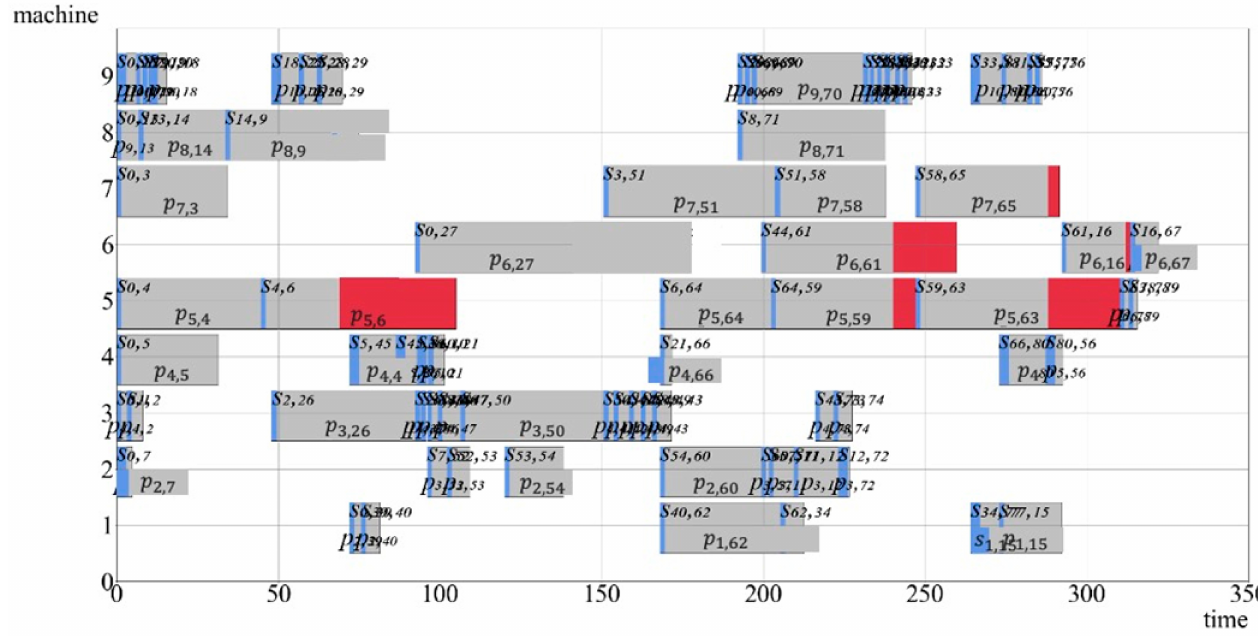
Figure 8. Gantt chart after decoding the current scheduling method. The Pareto chart drawn according to the final solution after the execution of the pro- posed non-dominated sorting algorithm used in this study is shown in Figure 9. According to the two objective equations discussed in this study, the horizontal axis represents the makespan and the vertical axis represents the total tardiness. The yellow triangle means the feasible solution corresponding to the point is the Pareto front solution, i.e., the non- dominated solution. The optimal solution set was obtained using the algorithm. The corresponding two target values are shown in Table 5.